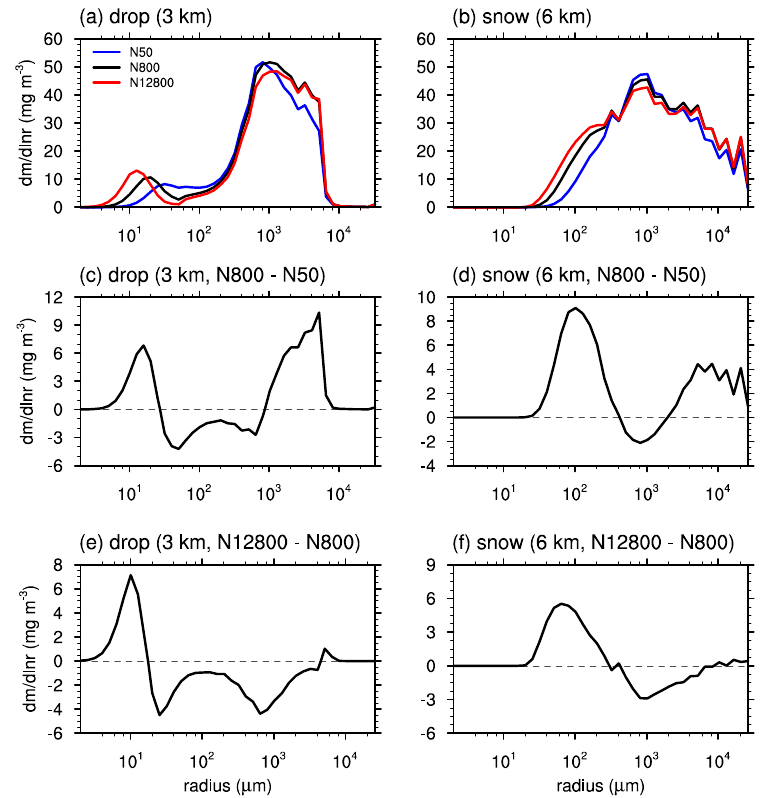
Figure 9. Size distributions of ( a ) drop mass at z = 3 km and ( b ) snow mass at z = 6 km in the N 0 = 50, 800, and 12,800 cm − 3 cases. Differences in the size distributions of ( c ) drops and ( d ) snow particles between the N 0 = 800 cm − 3 and N 0 = 50 cm − 3 cases. Subfigures ( e , f ) are analogous to ( c , d ), but for the differences between the N 0 = 12,800 cm − 3 and N 0 = 800 cm − 3 cases.